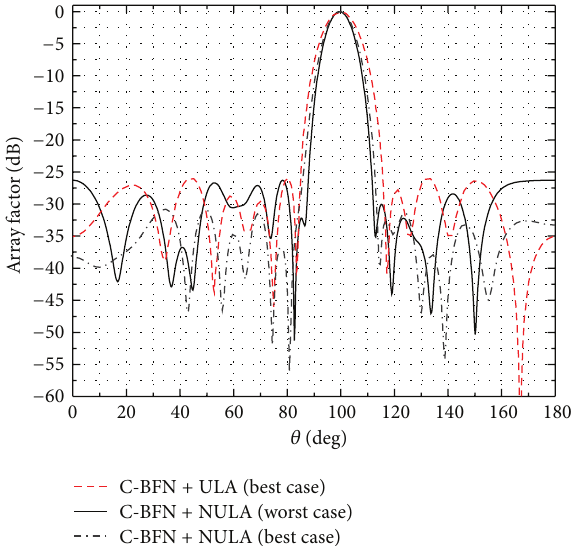
Figure 5: Comparison between the array factor of the best case of a ULA, the worst case of a NULA, and the best case of a NULA obtained by the proposed C-BFN, showing an example of beam #2 directed at 100 ∘